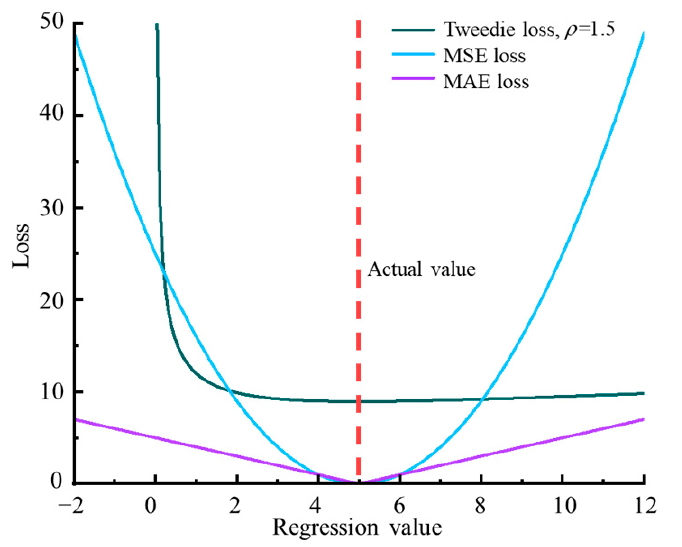
Figure 1. Comparison of Tweedie loss with MAE and MSE losses.